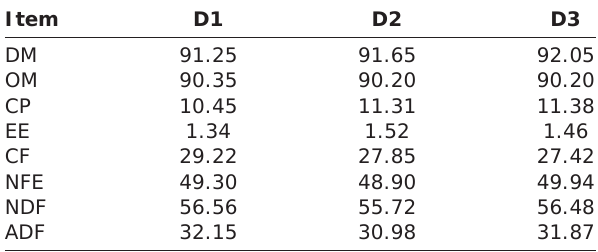
Table-3: Chemical composition (% DMB)* of experimental complete diets.